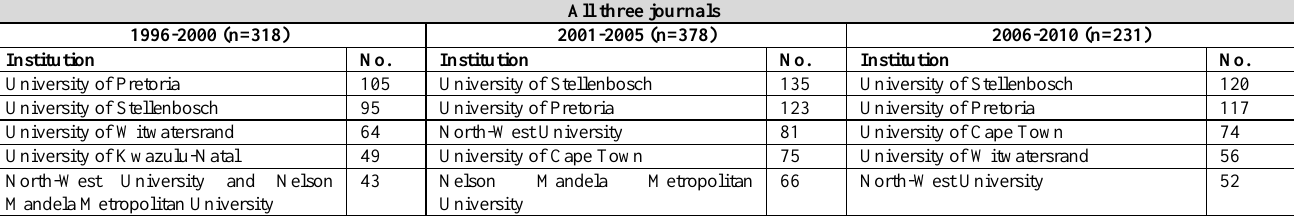
Table 4: Top five academic institution appearances